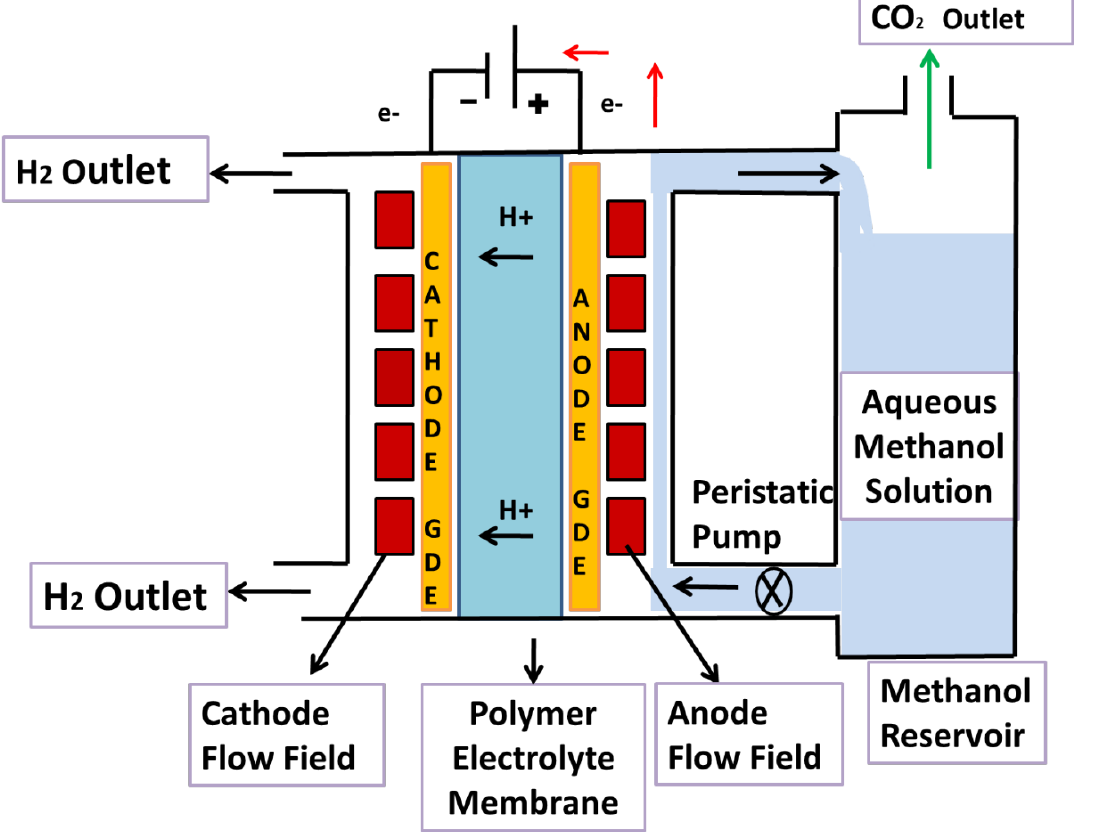
Figure 2. Schematic of polymer electrolyte membrane (PEM) methanol electrolyzer. Table 1. Comparison of di ff erent energy parameters such as onset potential / e ffi cient for di ff erent solvents to convert